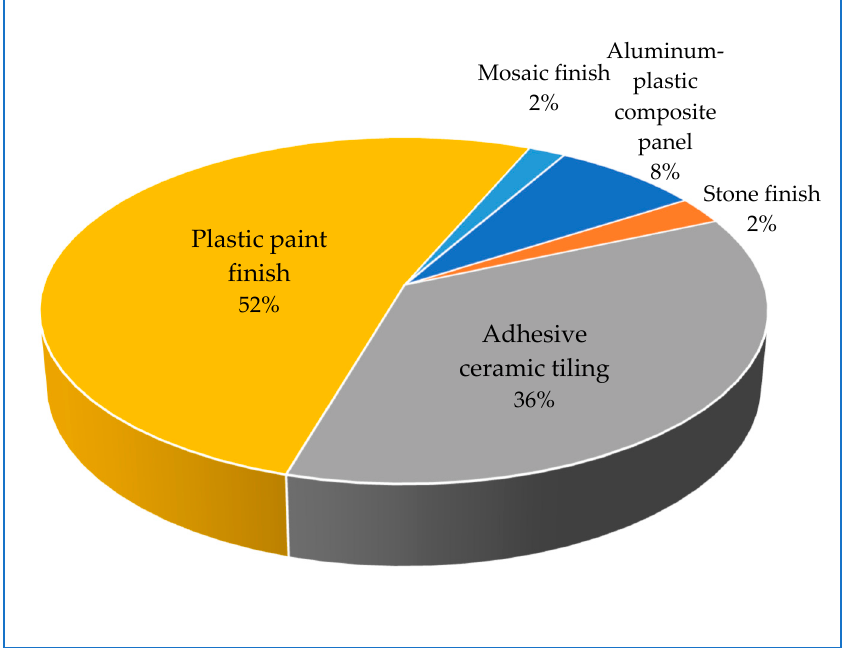
Figure 9. Proportion of the thermal insulation materials used in façades appearing with falling objects.